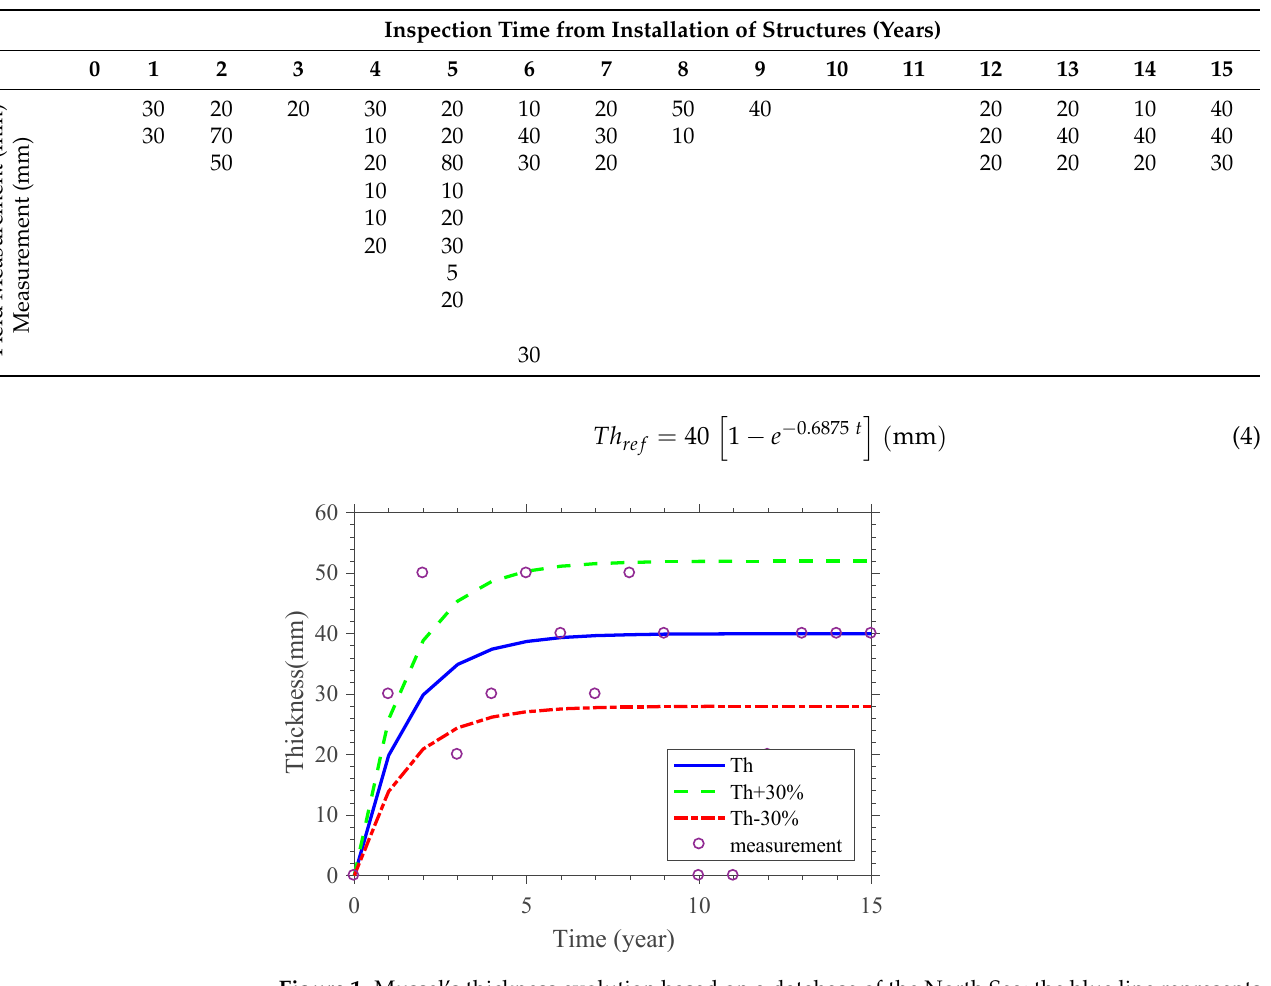
Figure 1. Mussel’s thickness evolution based on a database of the North Sea; the blue line represents the mean value trend and the red dashed line represents the mean ± standard deviation.